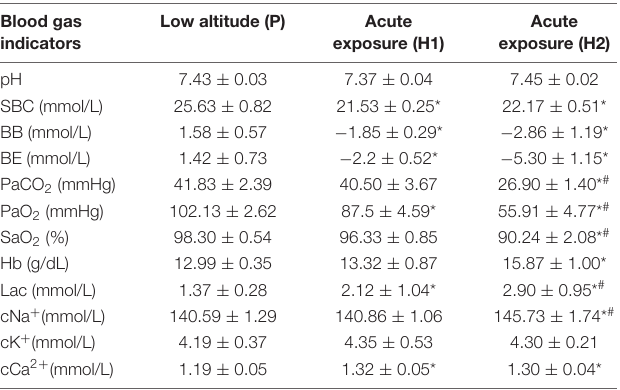
TABLE 1 | Results of blood gas analysis in rats at different groups (mean ± SD, n =